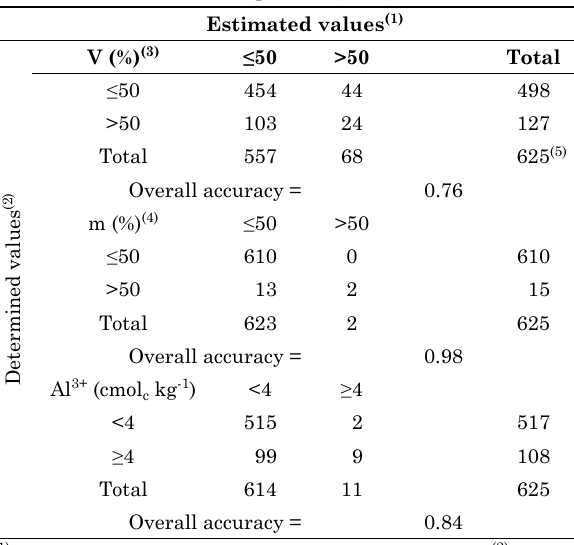
table 2. Matrix of accuracy and error of values determined in the laboratory by conventional soil analyses and values estimated by multiple regression equations for the variables